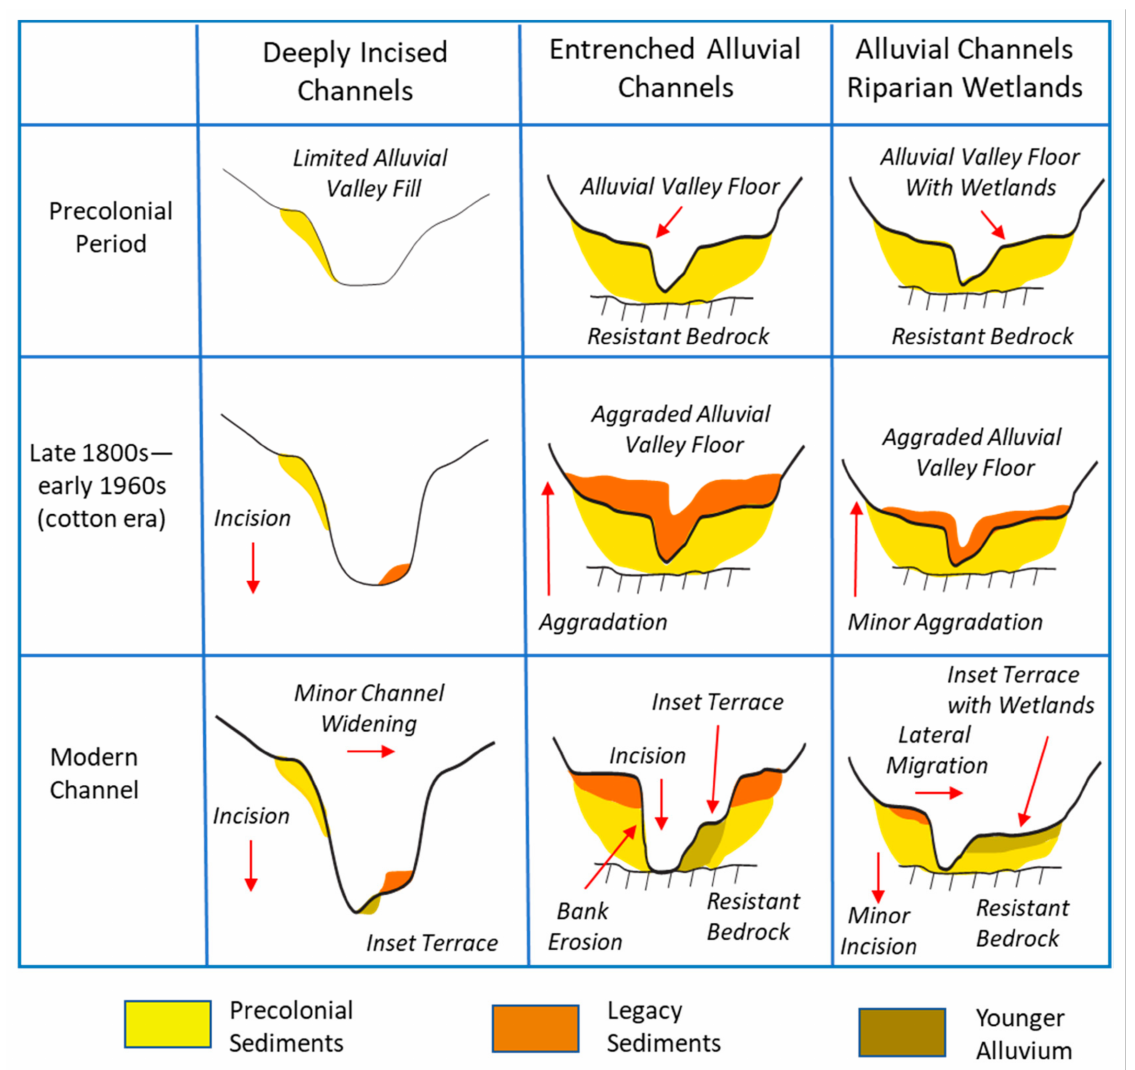
Figure 7. Schematic of channel and valley evolution since European settlement along the predominant process zone types in Big Harris Creek. Evolutionary pathways based primarily on topographic and stratigraphic data collected along the drainage